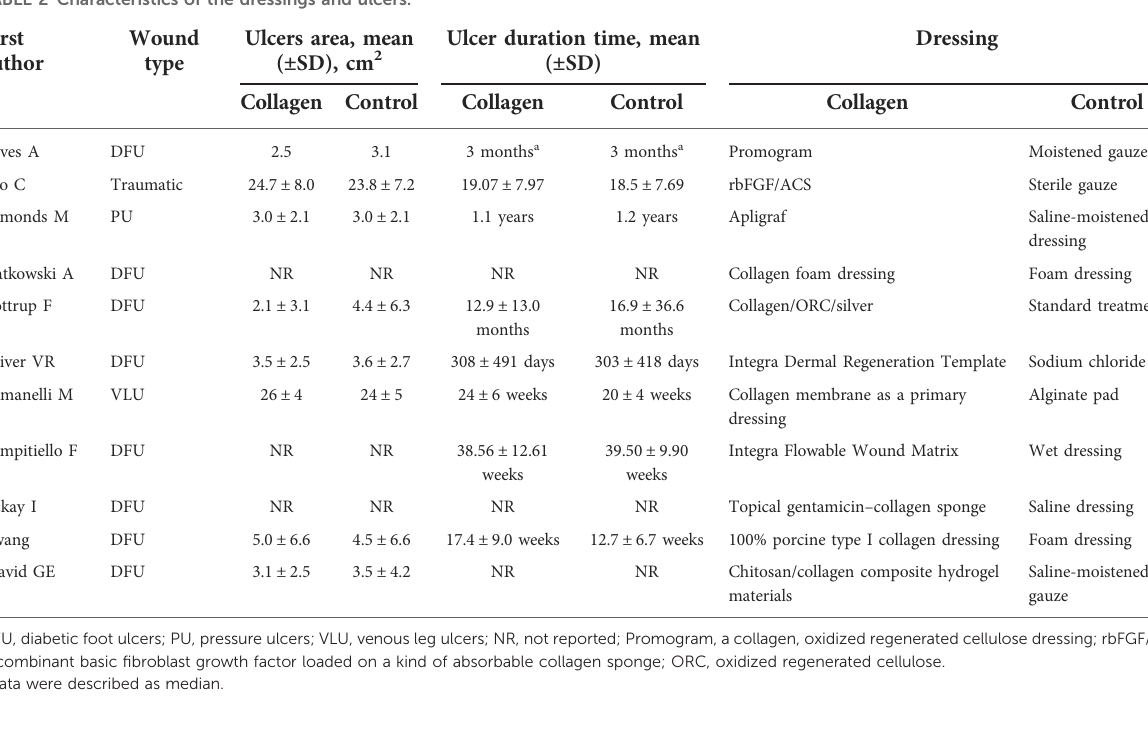
TABLE 2 Characteristics of the dressings and ulcers.